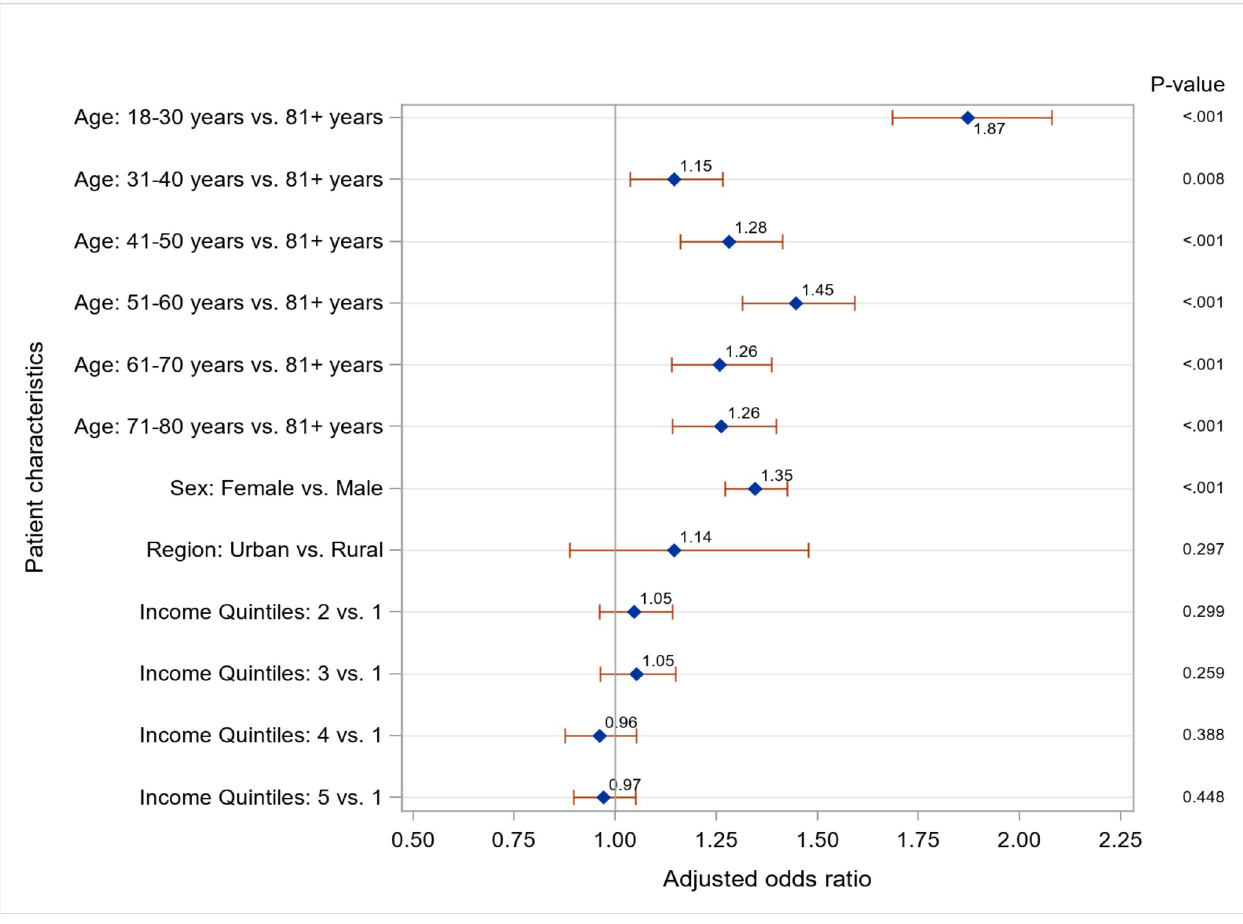
Fig 3. Adjusted odds ratios for a diagnosis of mental health